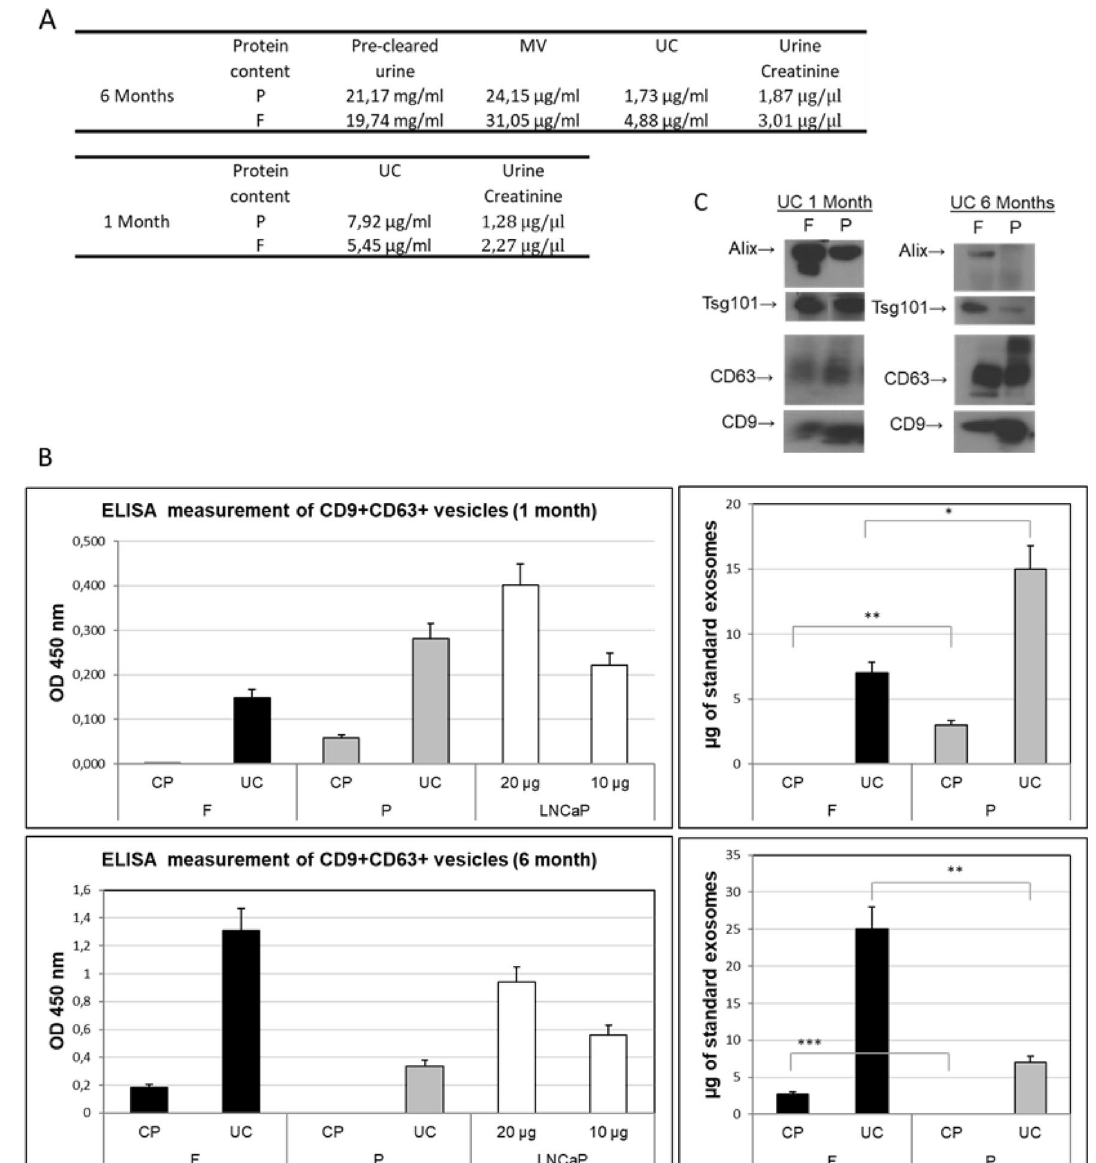
Figure 2. Quantitative analysis of EVs protein content. EVs were purified from urine obtained from three healthy volunteers, and 2 independently processed aliquots from each donor. The urines were either frozen at – 80 °C (F) or adjuvated with the preservant and stored at room temperature (P), After 1 and 6-months long sample storage, EV isolation was done by differential ultracentrifugation (UC) and chemical precipitation (CP). The Figure shows the total protein content measured by BCA assay, and creatinine content determined in whole urine and in urine microvesicles (MV) pellet and EV isolates from a single representative donor ( A ). For the same donor samples the specific content of canonical EV proteins was addressed by Western Blot ( C , namely CD63, CD9, Tsg101 and Alix) ( C ) CD63 and CD9 expression was also measured for all analyzed samples